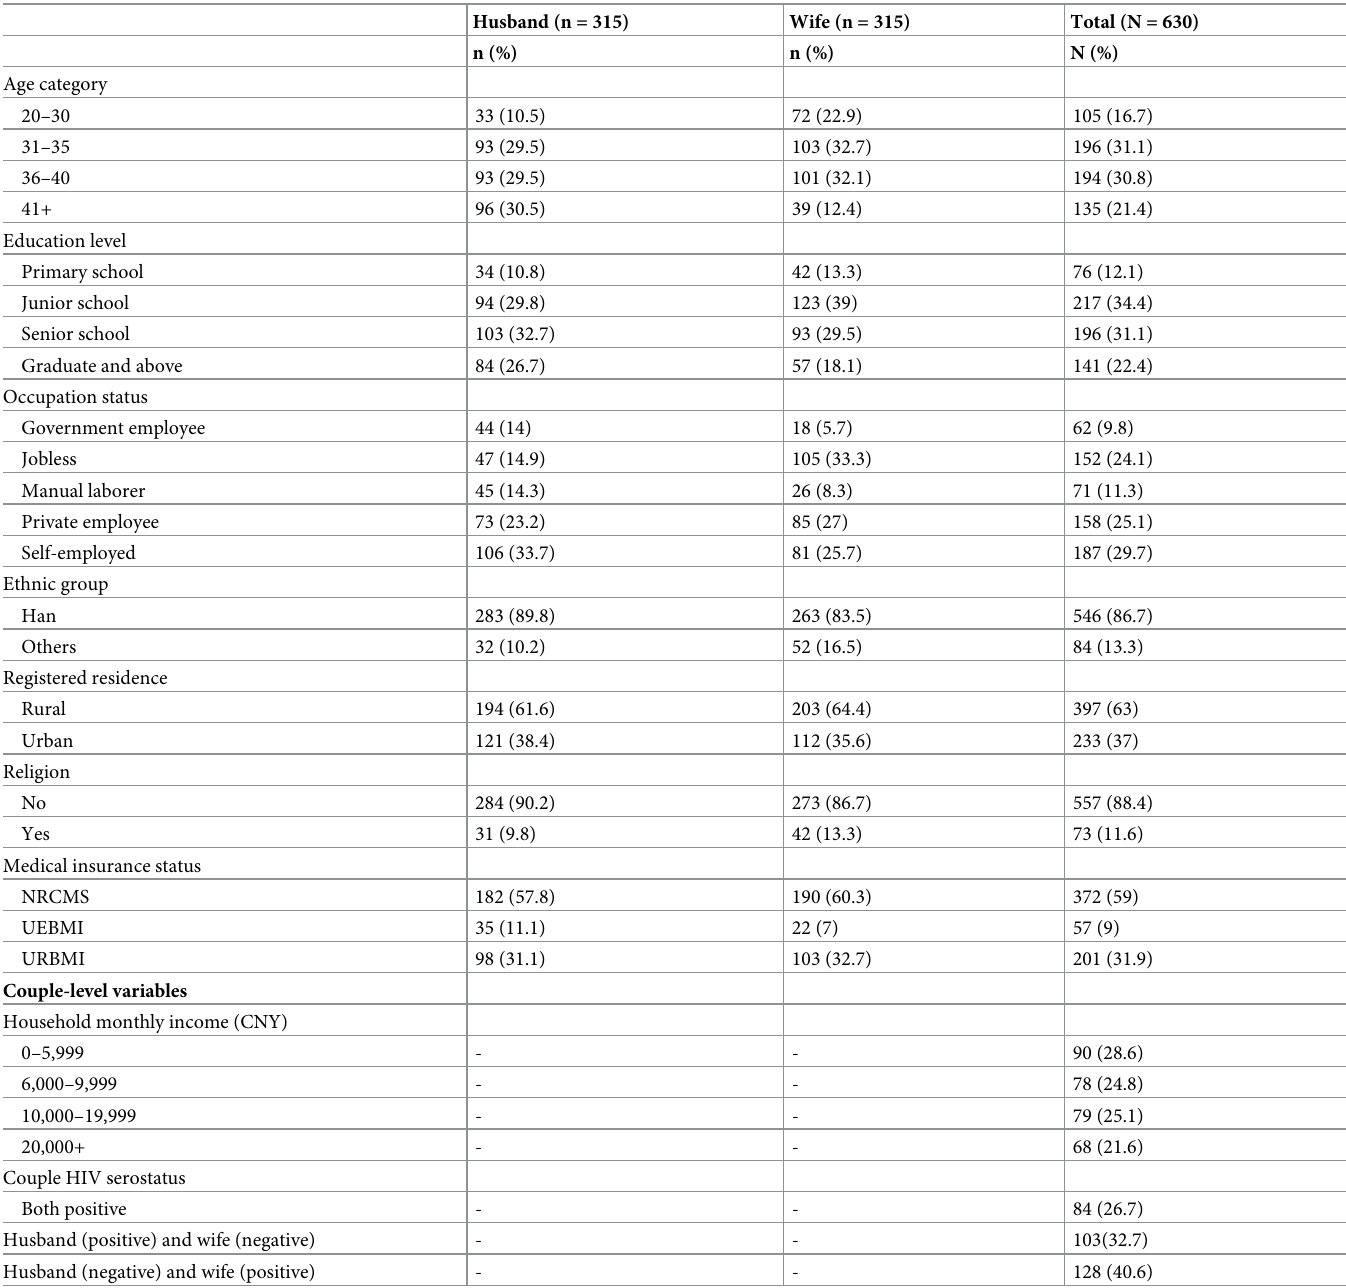
Table 1. Socio-demographic and HIV-related